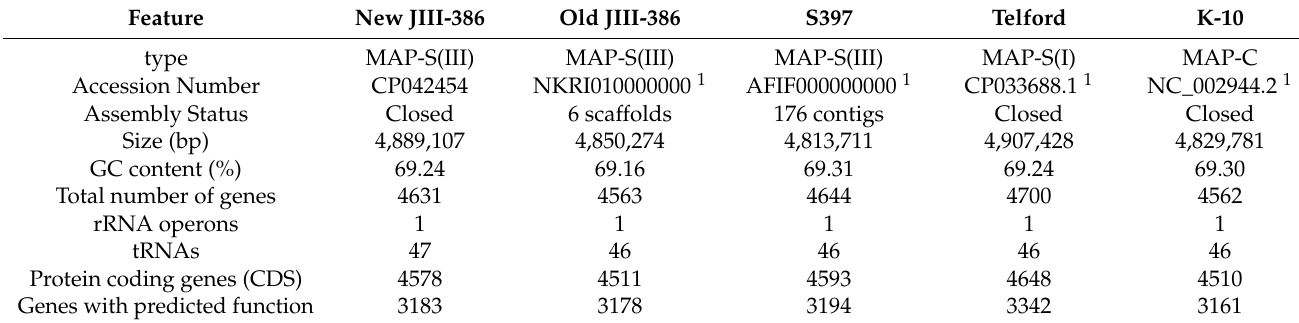
Table 2. General genome features of different M. avium subsp. paratuberculosis (MAP)